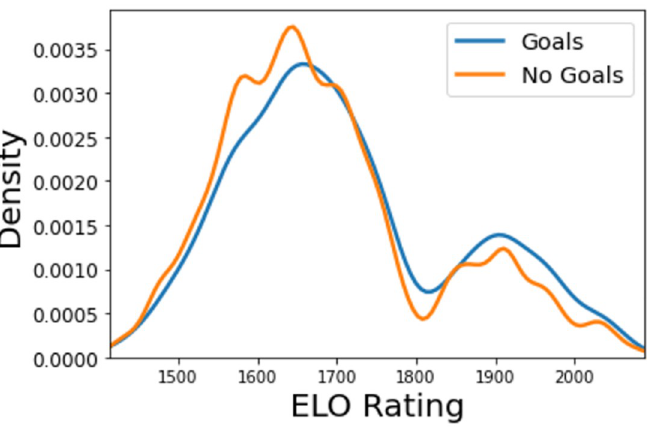
Fig 7. Kernel density estimate of the ELO